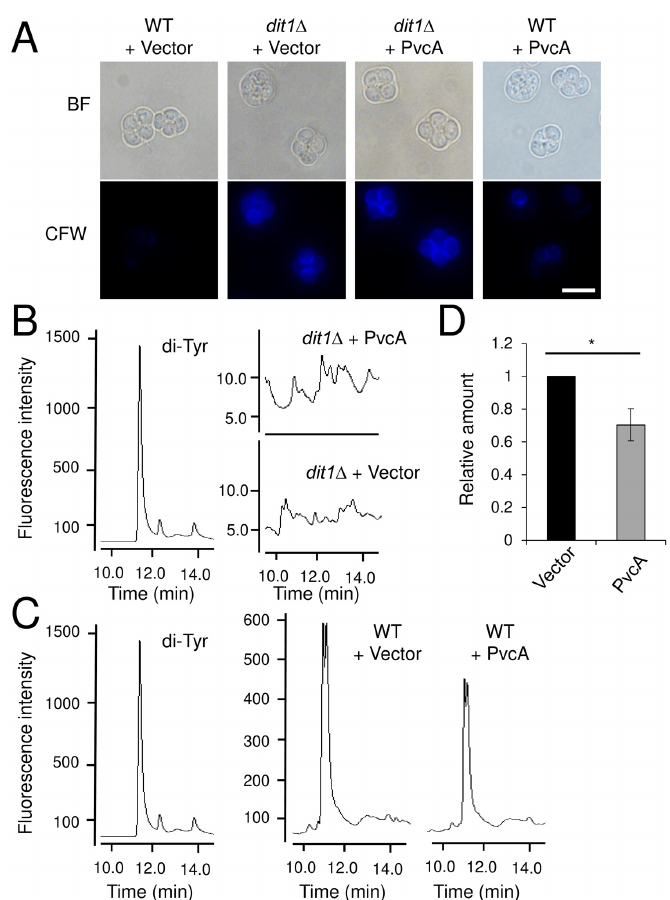
Figure 1. Heterologous expression of P. aeruginosa PvcA in yeast cells. ( A ) Wild-type (WT) or dit1 ∆ spores harboring pRS316TEF-PvcA (PvcA) or pRS316TEF (Vector), were stained with CFW and observed by bright field (BF) or florescence microscopy (CFW). Bar, 5 µ m. ( B ) Lysates of dit1 ∆ spores harboring pRS316TEF-PvcA (PvcA) and pRS316TEF (Vector) were hydrolyzed with 6 N HCl and subjected to HPLC analysis. Dityrosine (di-Tyr) is shown as a control. ( C ) Lysates of wild-type spores harboring pRS316TEF-PvcA (PvcA) or pRS316TEF (Vector) were hydrolyzed with 6 N HCl and subjected to HPLC analysis. Dityrosine (di-Tyr) was assayed as a control. ( D ) Lysates of wild-type spores harboring pRS316TEF-PvcA (PvcA) or pRS316TEF (Vector) were hydrolyzed with 6 N HCl and subjected to HPLC analysis. The relative amount of dityrosine detected by HPLC is shown. The data presented are the mean ± SE of six independent samples. * p <